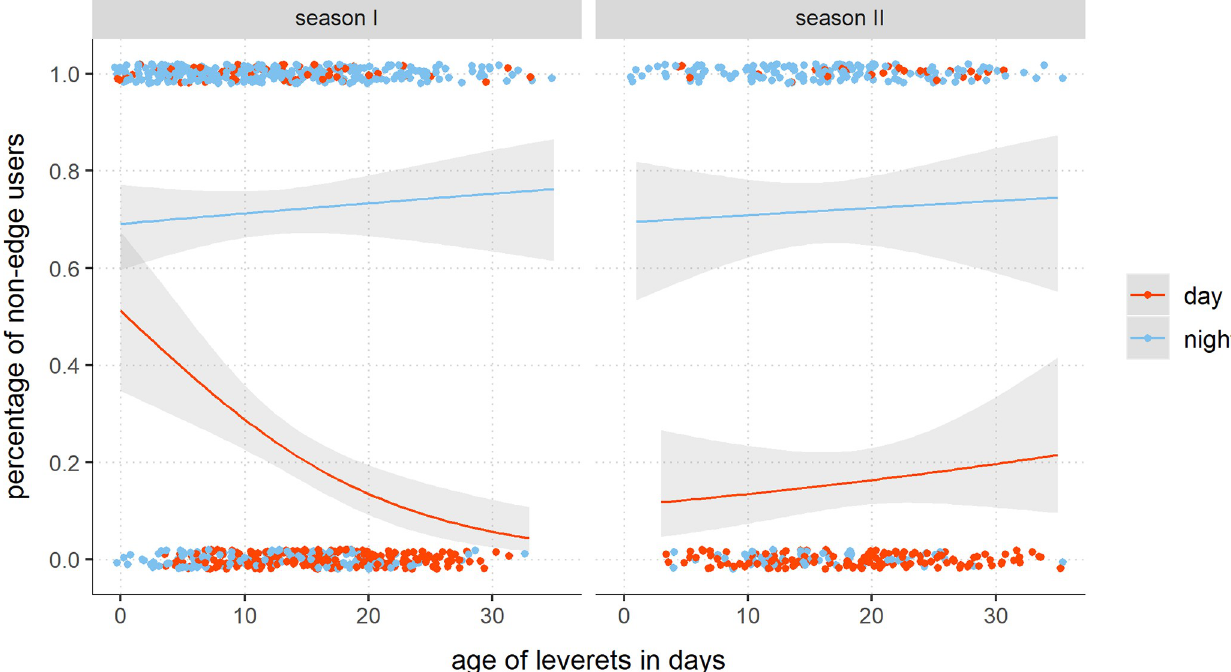
Fig 2. Diurnal and seasonal percentage of leverets using edges. The binomial generalized model shows the functional relationship between increasing age of juvenile hares and the usage of non-linear structures in the daytime (red dots and lines) and nighttime (blue dots and lines). The 95% confidence interval was shaded for day- and